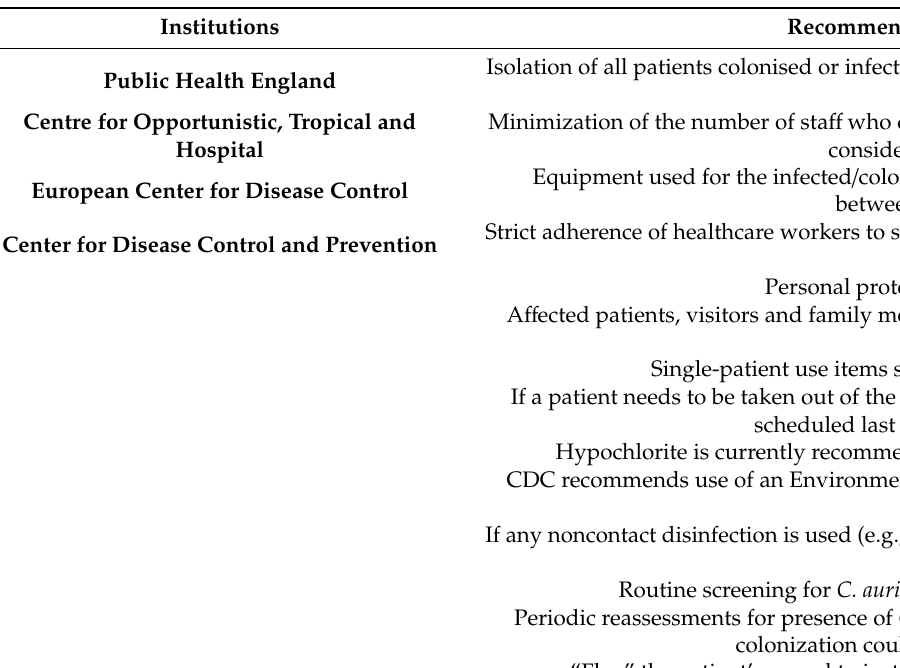
Table 1. Recommendations from the di ff erent institutions regarding infection control practices in C.